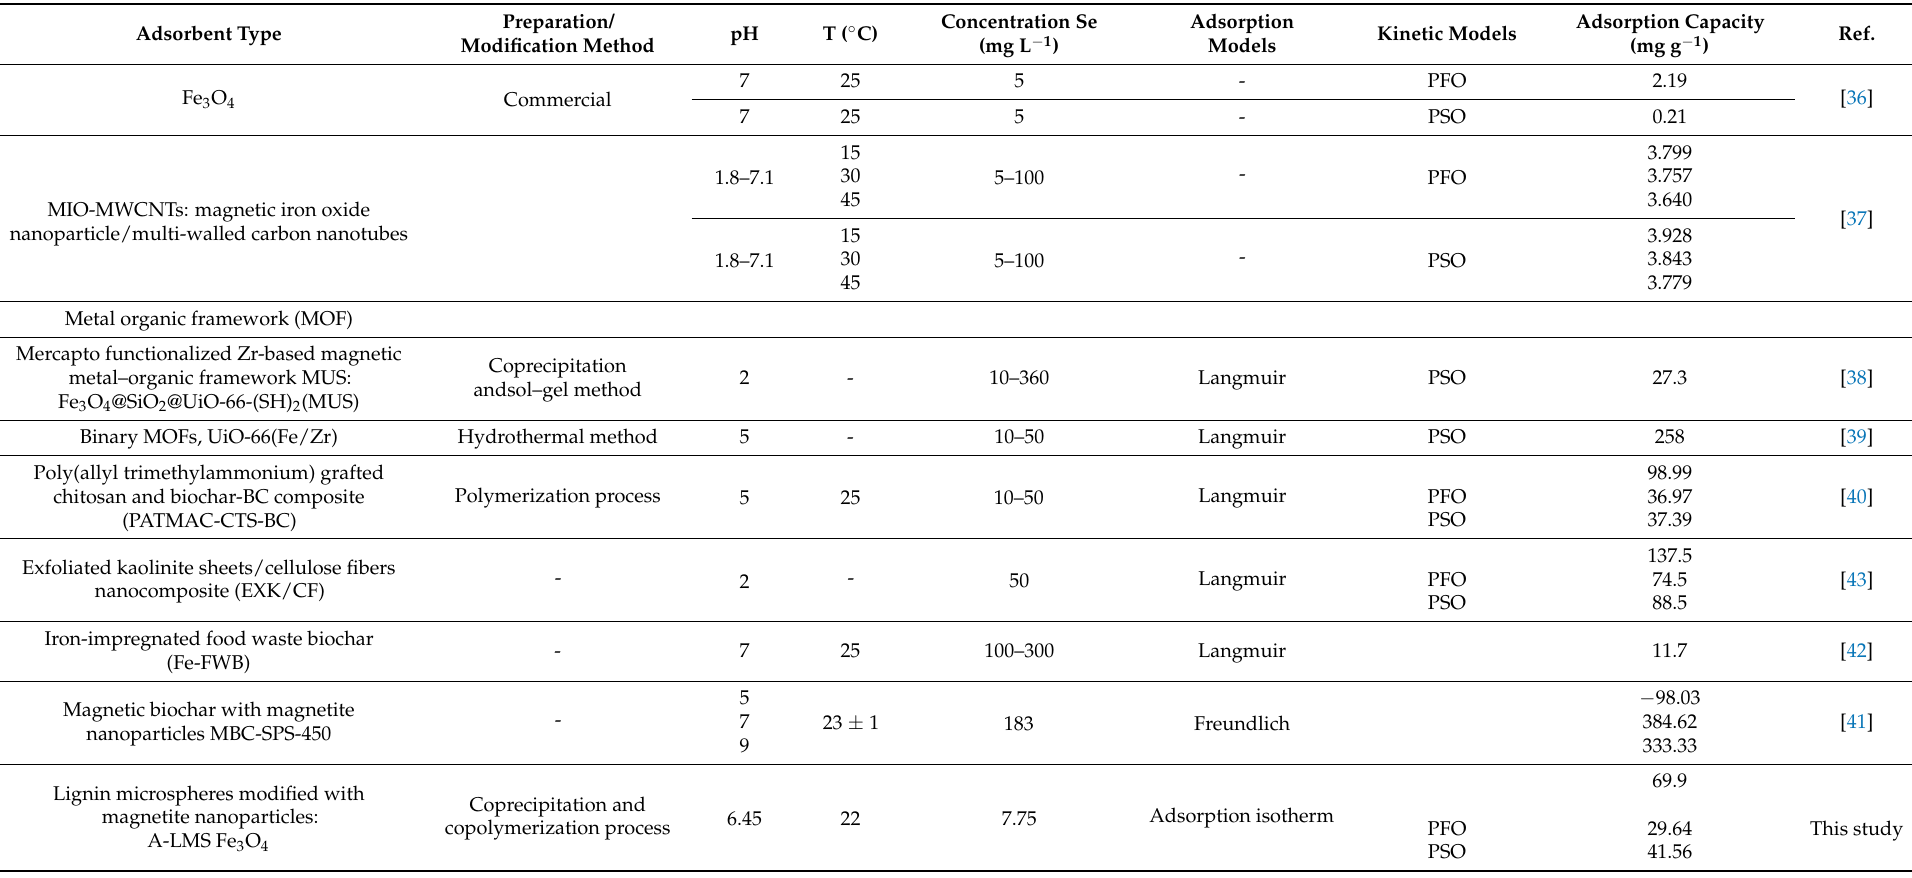
Table 4. Comparison of different type nanocomposite materials and magnetite for adsorption